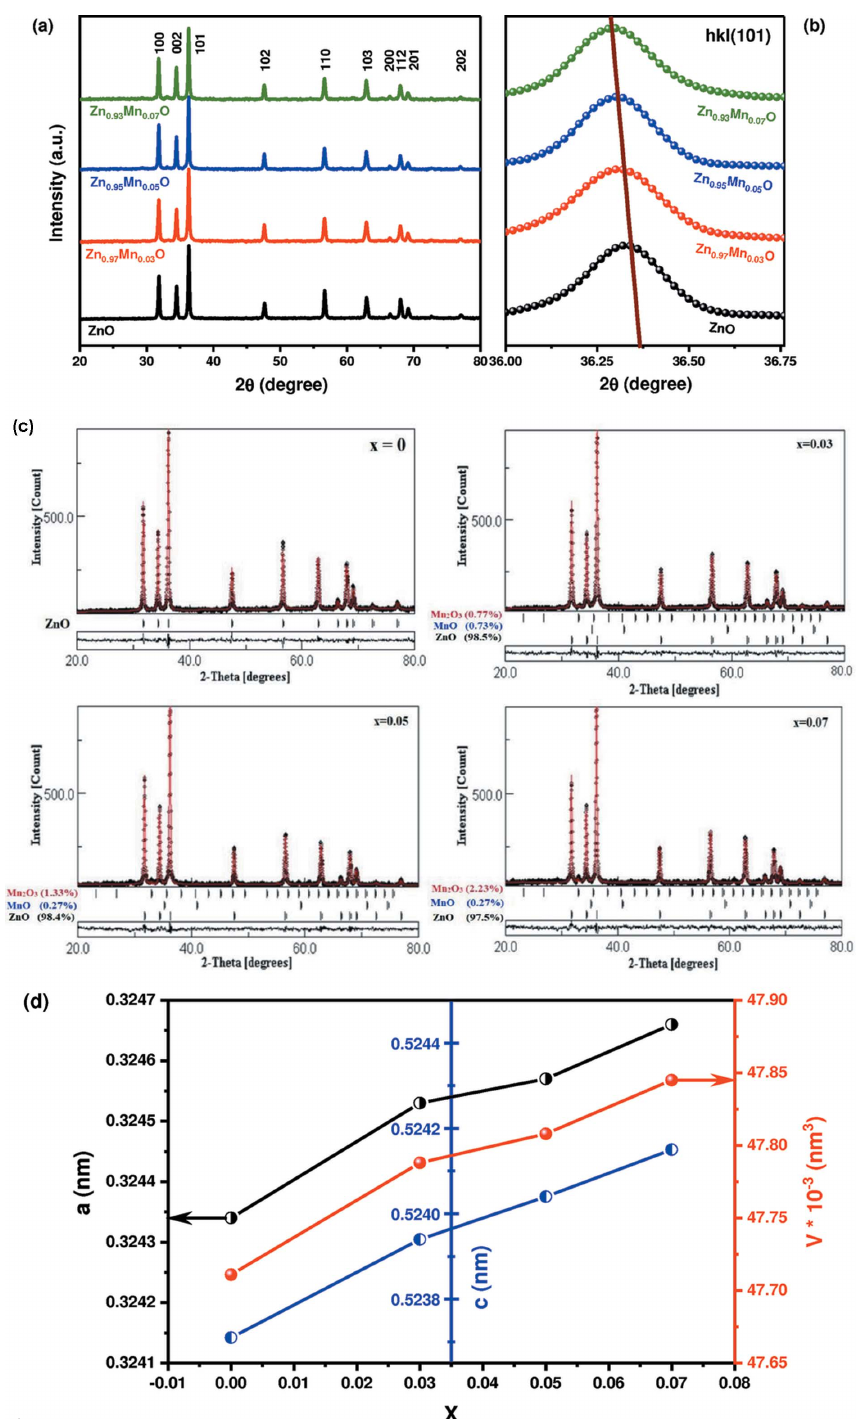
Figure 1 ( a , b ) XRD spectra, ( c ) Rietveld refinement, and ( d ) lattice parameters and unit-cell volume versus x